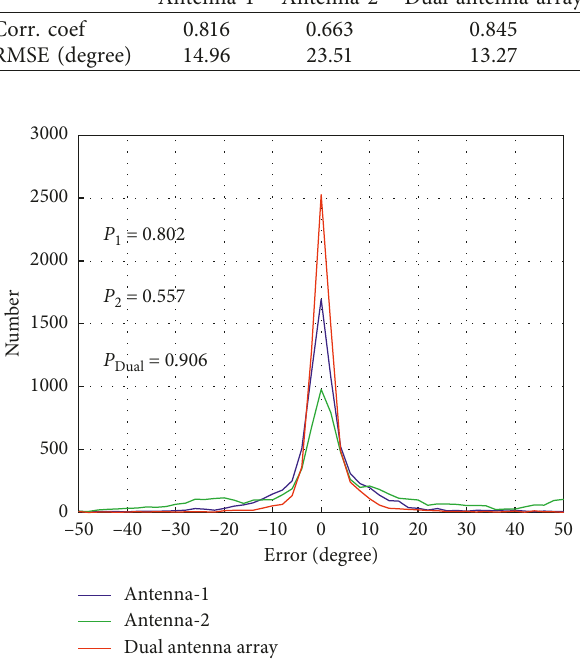
Figure 6: The error distribution of DOA estimation